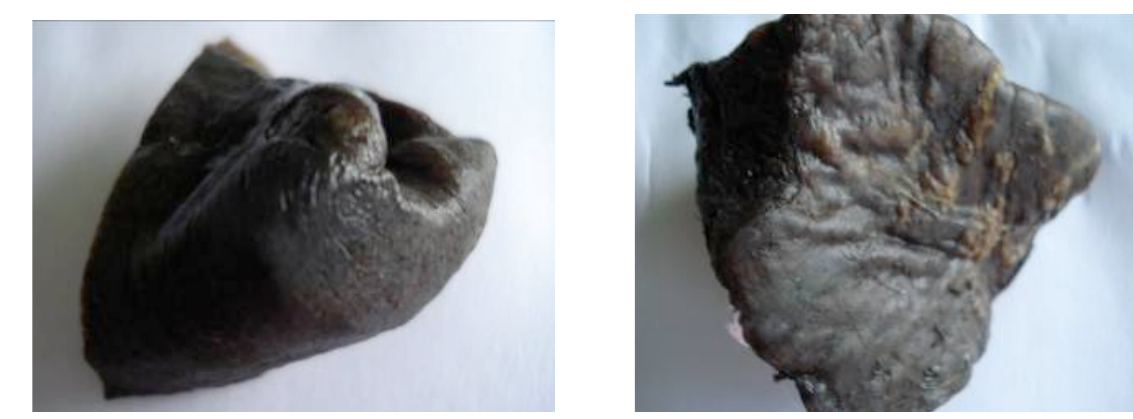
Image 7. Lung of Terrier dog showing massive black-brown coloration throughout the parenchyma